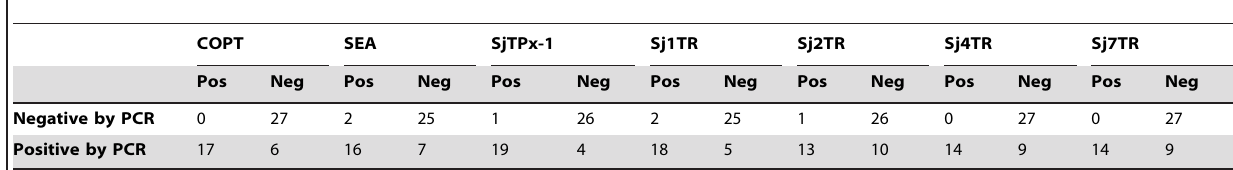
Table 1. Results tally of the samples for Schistosoma japonicum using serological tests and stool PCR.